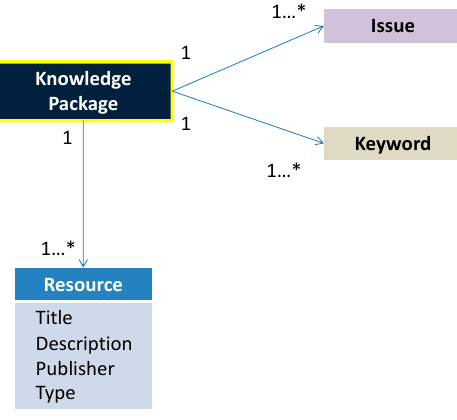
Figure 2. An ontology for representing the knowledge package resources.